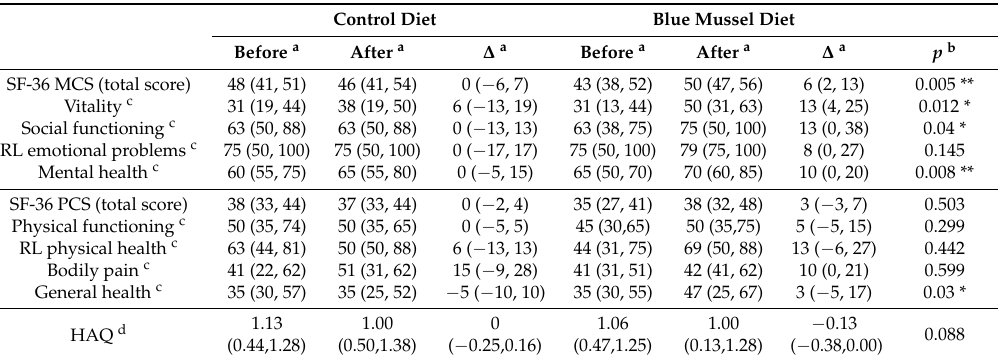
Table 5. Blue mussel diet versus control diet on quality of life. Control Diet Blue Mussel Diet Before a After a ∆ a Before a After a ∆ a p b